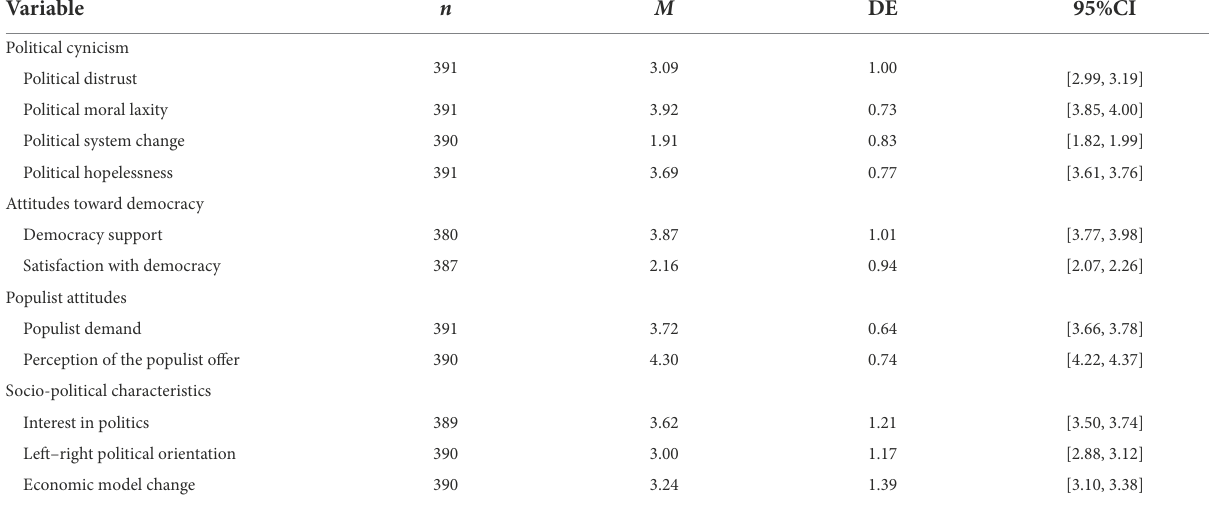
TABLE 1 Descriptive statistics of study